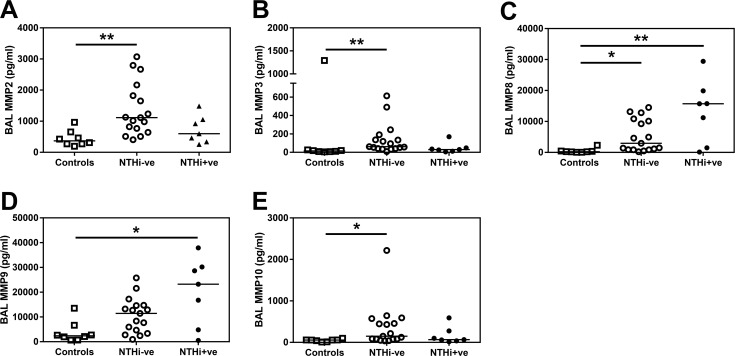
MMP levels are altered in COPD BAL.(A) MMP2, (B) MMP3, (C) MMP8, (D) MMP9 and (E) MMP10 in BAL derived from two lung lobes were analysed by Luminex multiplex assay and the average concentration from both lobes is presented. Open squares indicate controls, open circles indicate NTHi-ve COPD patients, closed circles indicate NTHi+ve patients. Bars represent median values and each dot represents an individual volunteer n = 8 for controls, n = 17 for NTHi-ve and n = 7 for NTHi+ve patients. Data were analysed using a Kruskal-Wallis ANOVA followed by a Dunn’s post hoc test. * p<0.05, ** p<0.01, *** p<0.01.